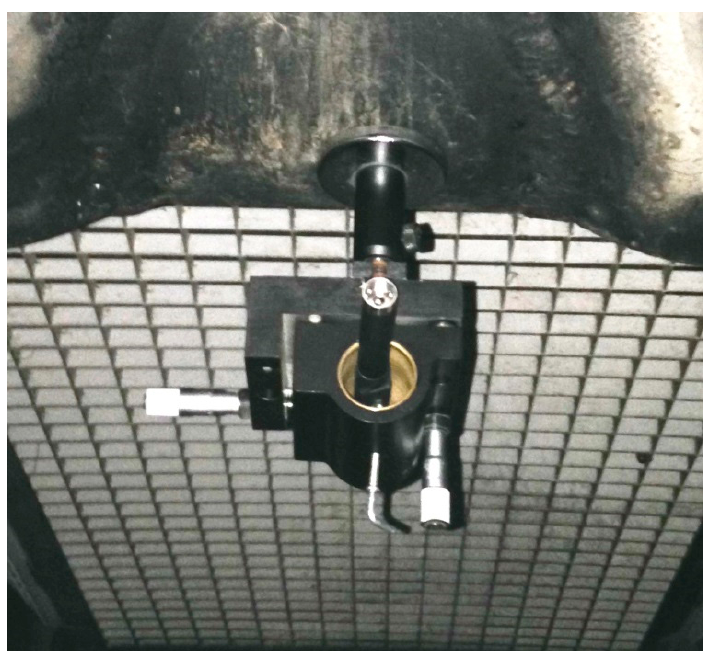
Figure 6. The laser pointer and the holder.